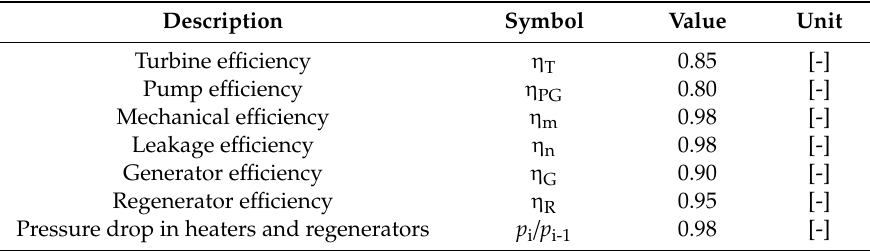
Table 3. Assumed values of the e ffi ciencies of particular cycle elements.